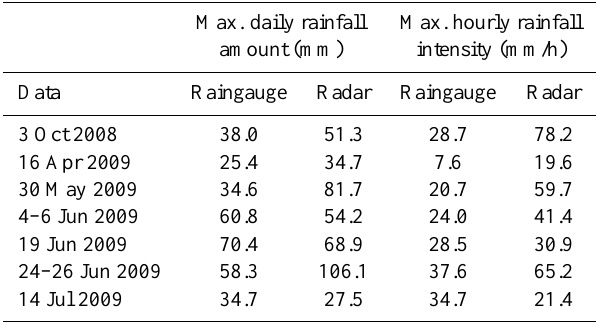
Table 2. Configuration of different simulations of MM5 model: Ini- tial conditions (IC), Lateral Boundary Conditions (LBC), and Con- vection (CONV), Microphysics (MICRO)